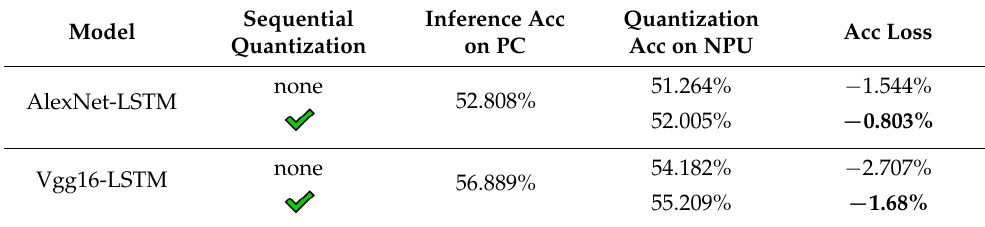
Table 7. Experiment on sequential quantization calibration.